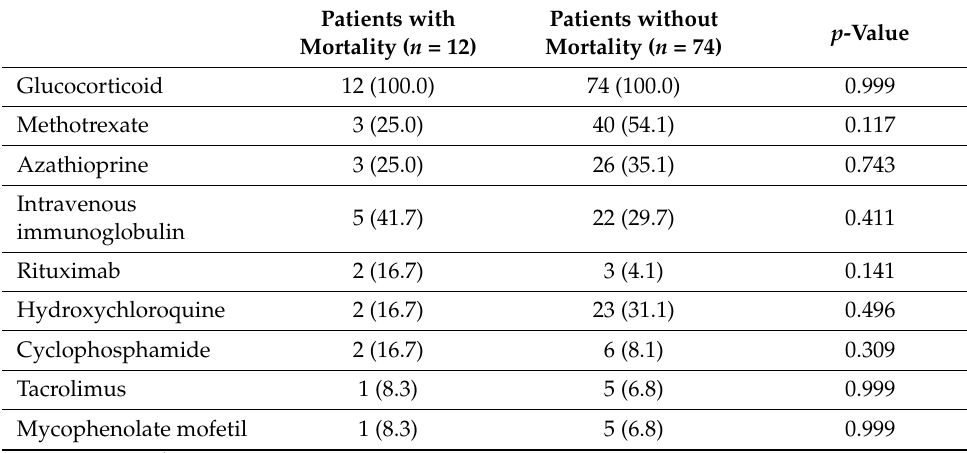
Table 5. Medications administered to patients in relation to their death or survival.